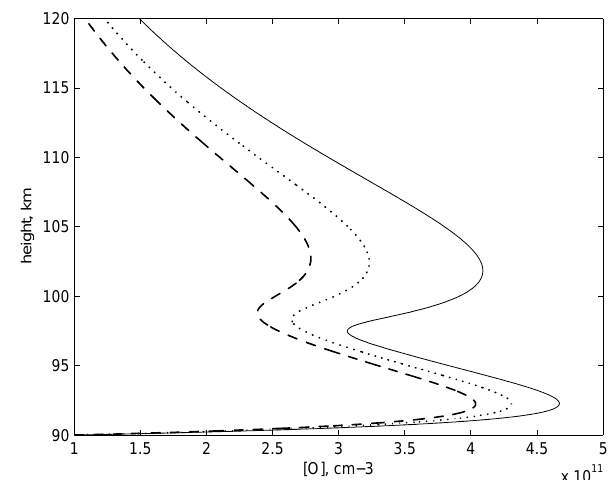
Fig. 6. Dependence of the maximum heating rate on the Richardson number for the eddy diffusion shown in Fig. 5 and corresponding to conditions for the heating rate shown in Fig. 4.